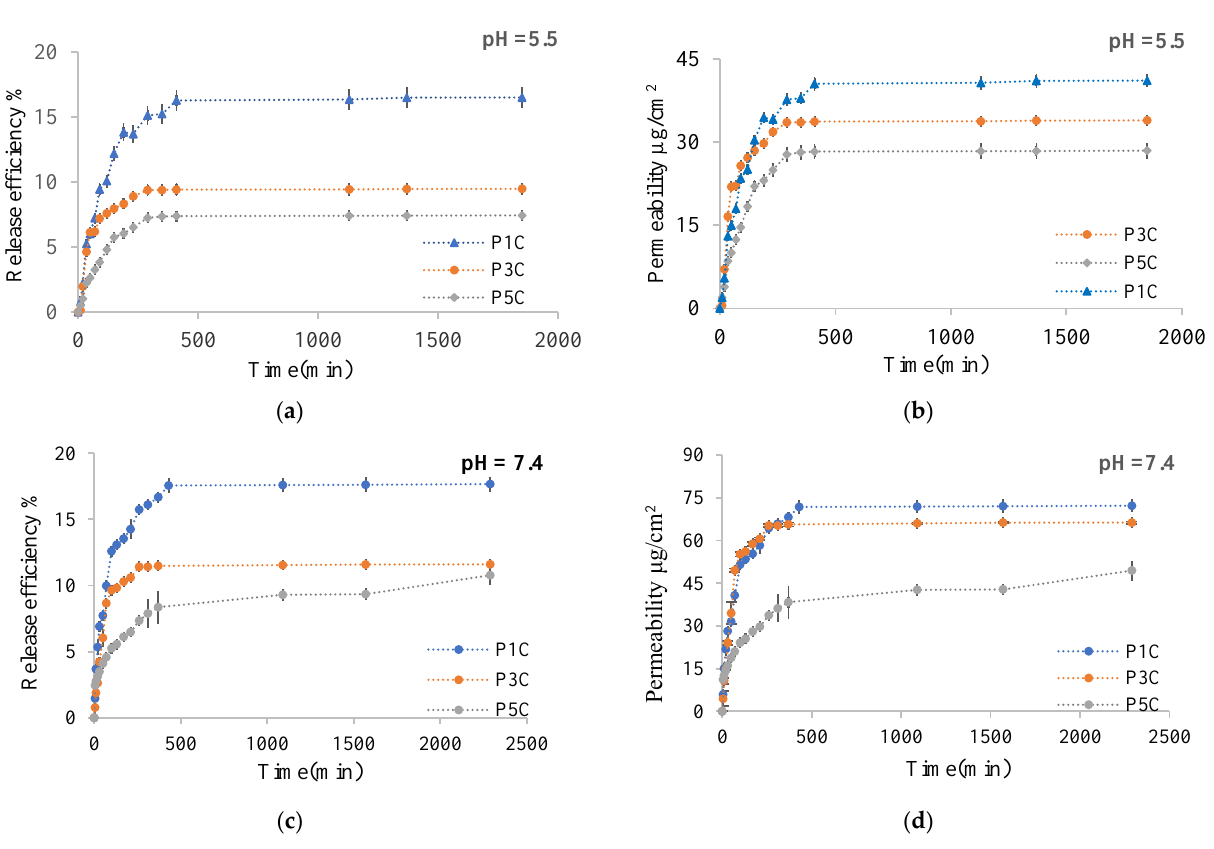
Figure 13. The curcumin release kinetics in time in acetate buffer solution at pH = 5.5 expressed as release efficiency ( a ) or in terms of permeability-μg/cm 2 ( b ) and phosphate buffer solution at pH = 7.4 expressed as release efficiency ( c ) or in terms of permeability-μg/cm 2 ( d ), for samples P1C, P3C, and P5C.